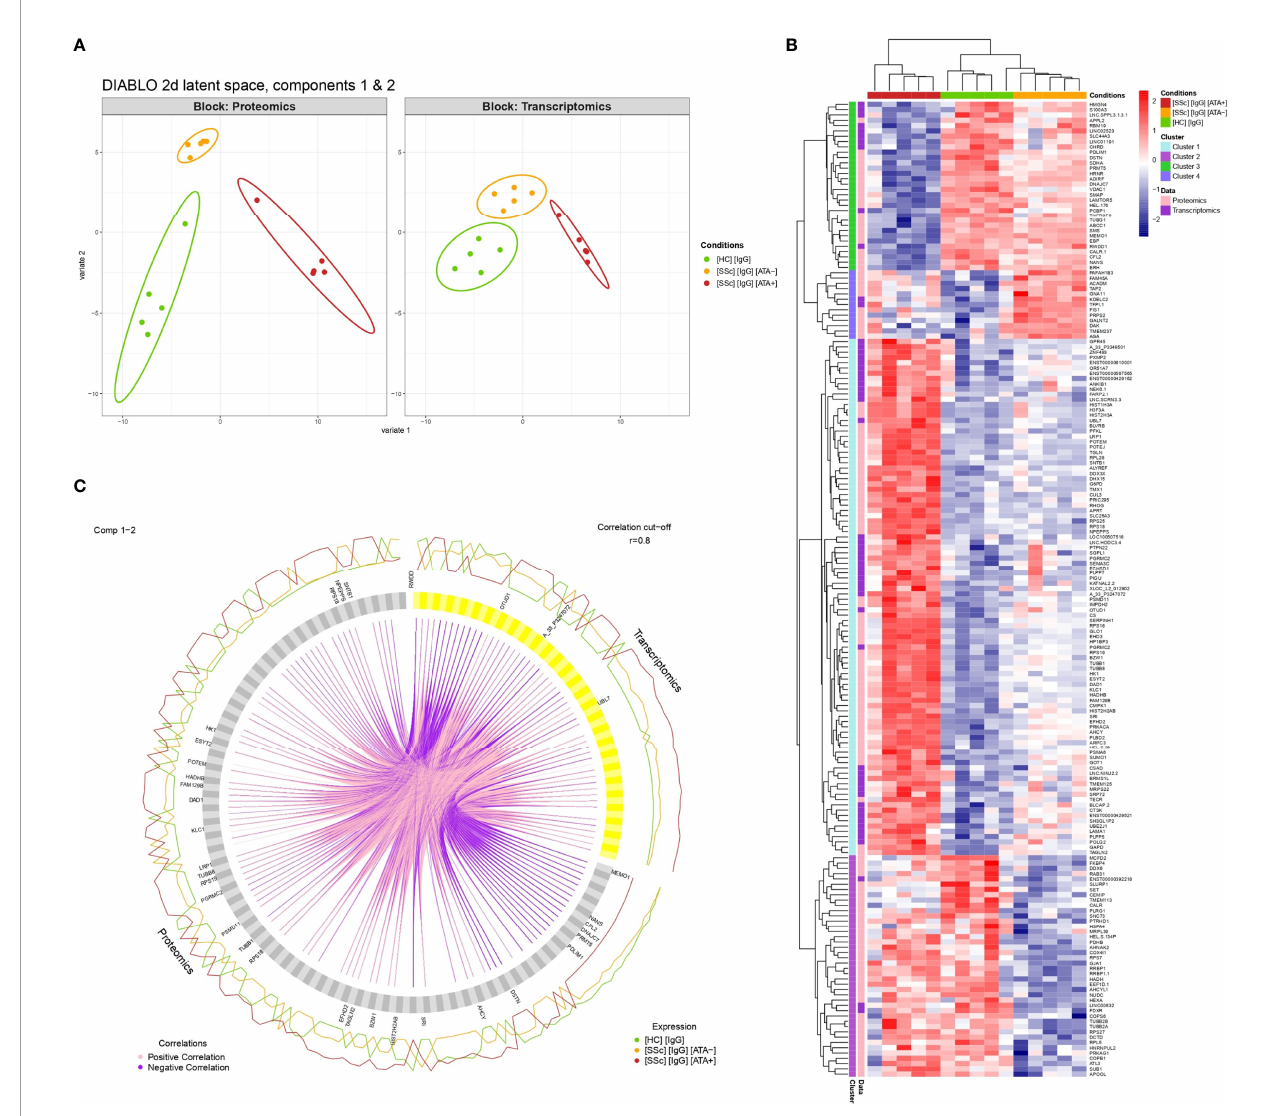
FIGURE 6 | Multi-omics data integration. (A) Individual plots representing patients ’ projections into the 2D proteomics and transcriptomics space. X and Y-axes correspond to the fi rst and second latent components of the DIABLO algorithm related to either proteomics (Block: Proteomics) or transcriptomics (Block: Transcriptomics) variables. (B) Circle plot representing variables with positive and negative correlation between proteomics and transcriptomics with r > 0.8. Only variables with r > 0.9 are tagged. (C) Heatmap representing clustering results of multi-omics signature identi fi ed by the DIABLO algorithm. [SSc] [IgG] [ATA+], IgG from dcSSc anti-topoisomerase-I positive patients; [SSc] [IgG] [ATA − ]: IgG from dcSSc anti-topoisomerase-I negative patients; [SSc] [IgG] [ACA+], IgG from dcSSc anti-topoisomerase-I negative patients; [HC] [IgG], IgG from healthy